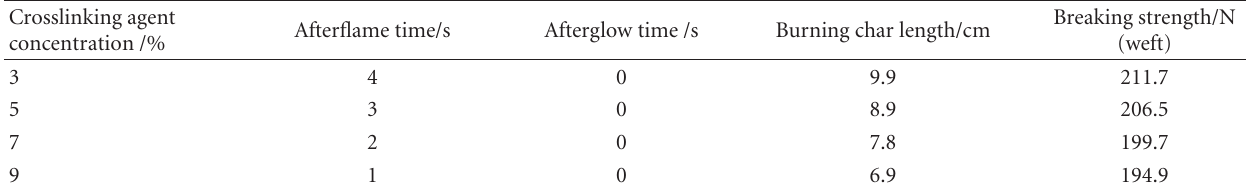
Table 5: E ff ect of the crosslinking agent concentration on the fire-retardant performance.